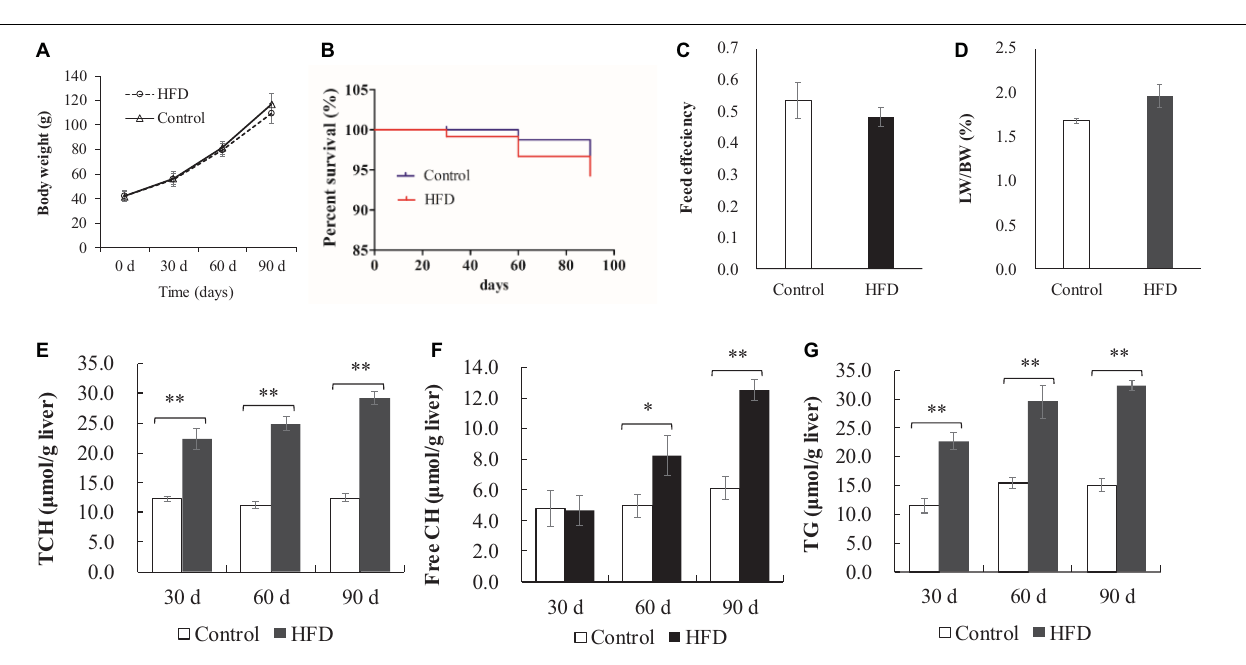
FIGURE 3 | Growth performance and liver lipid content in control diet and HFD-fed tilapia. (A) Body weight and (B) survival of tilapia were measured every 30 days ( n = 40–23). (C) Feed efficiency and (D) LW/BW were measured at 90 days ( n = 20). (E–G) Changes of TCH, free CH and TG in liver ( n = 10). All values are expressed as mean ± SEM. ∗ P < 0.05 and ∗∗ P < 0.01 versus control at same time. Feed efficiency = wet weight gain/dry feed intake; LW, liver weight; BW, body weight.